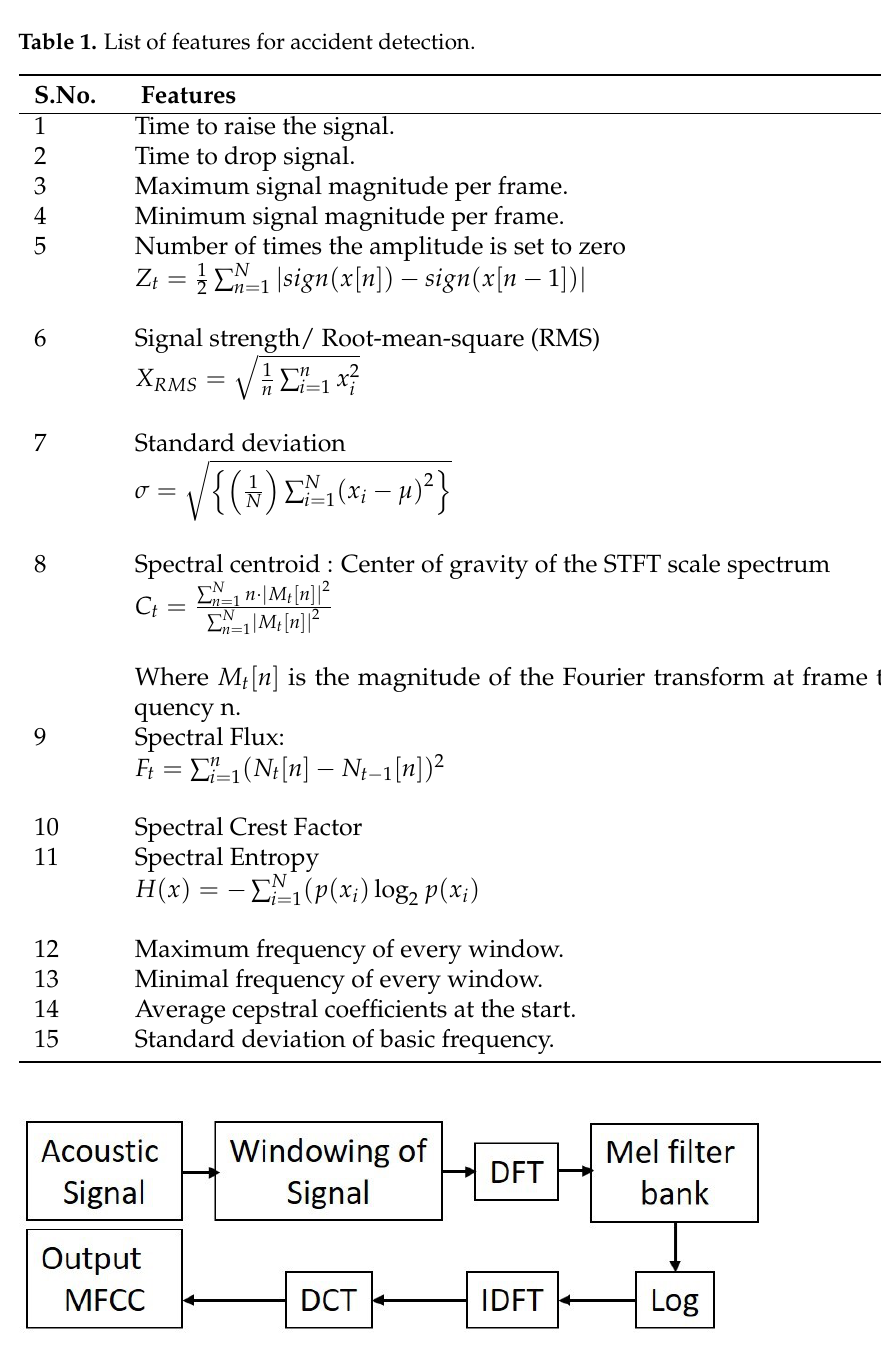
Figure 6. Mel Frequency Cepstral Coefficients (MFCC) block